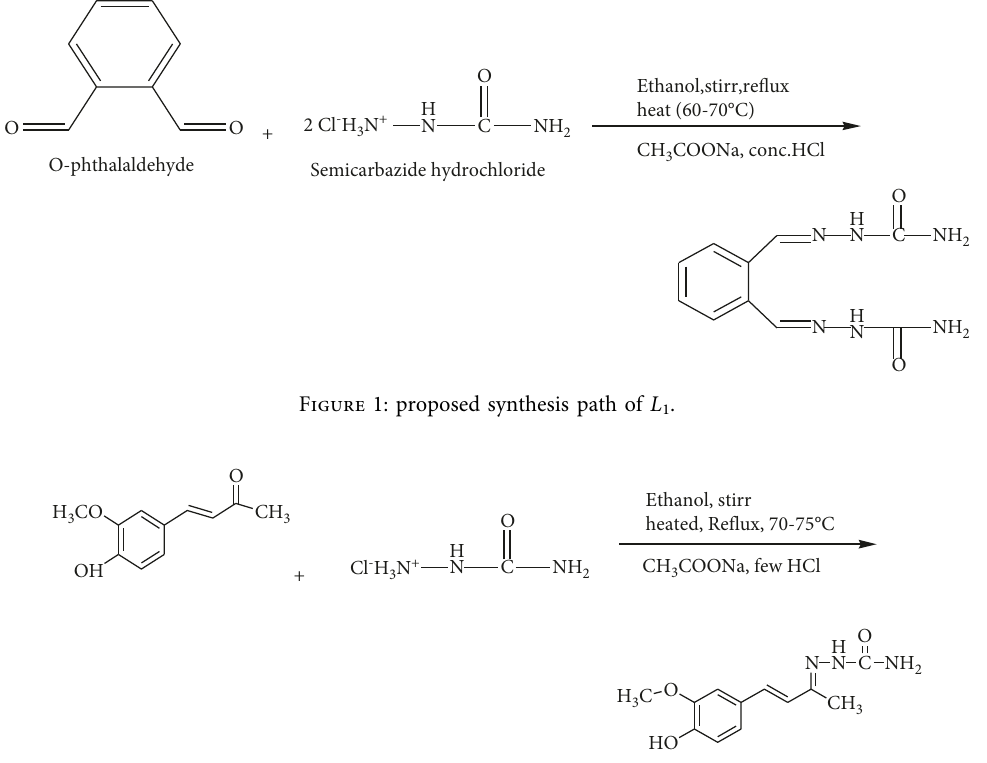
Figure 2: proposed synthesis path of L